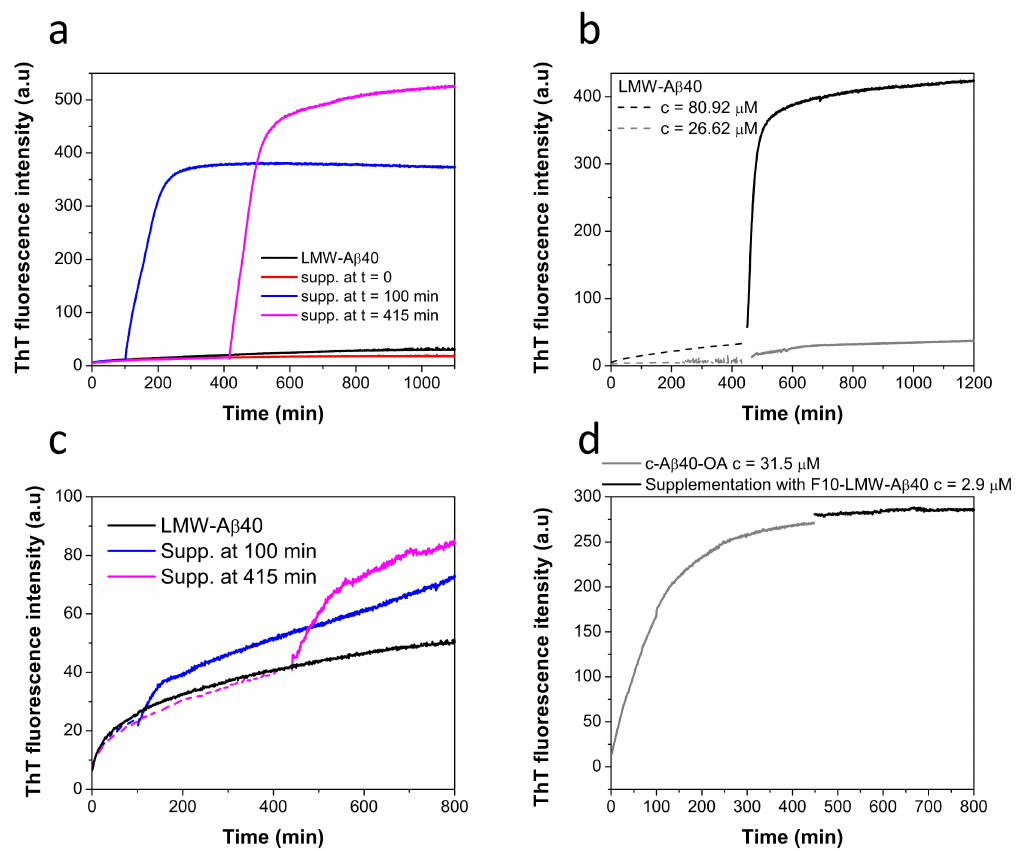
Figure 6. ( a ) Time dependent effect of the supplementation with F10-A β 40-OA on the aggregation kinetics of LMW-A β 40 at c = 86 µ M (black line) followed by ThT fluorescence. LMW samples were incubated at 37 ◦ C and supplemented with 2 µ M of F10-A β 40-OA at t = 0 (red line), t = 100 min (blue line), and t = 415 min (magenta line). ( b ) Effect of the supplementation with F10-A β 40-OA on the aggregation kinetics of LMW-A β 40 at c = 81 µ M (black line) and at c = 27 µ M (grey line) followed by ThT fluorescence. Samples were incubated at 37 ◦ C for about 400 min (dashed lines) prior to supplementation with 1.9 µ M F10-A β 40-OA (continuous lines). ( c ) Time dependence effect of the supplementation with F10-LMW-A β 40 on the aggregation kinetics of LMW-A β 40 at c = 85 µ M (black line) followed by ThT fluorescence. LMW samples were incubated at 37 ◦ C and supplemented with 2 µ M of F10-LMW-A β 40 at t = 100 min (blue line), and t = 415 min (magenta line). Data were normalized by sample concentration and experimental points before supplementation are represented in dashed lines. ( d ) Effect of the supplementation with 2.9 µ M of F10-LMW-A β 40 (black line) on the aggregation kinetics of pre-incubated c-A β 40-OA at c = 32 µ M (grey line) followed by ThT